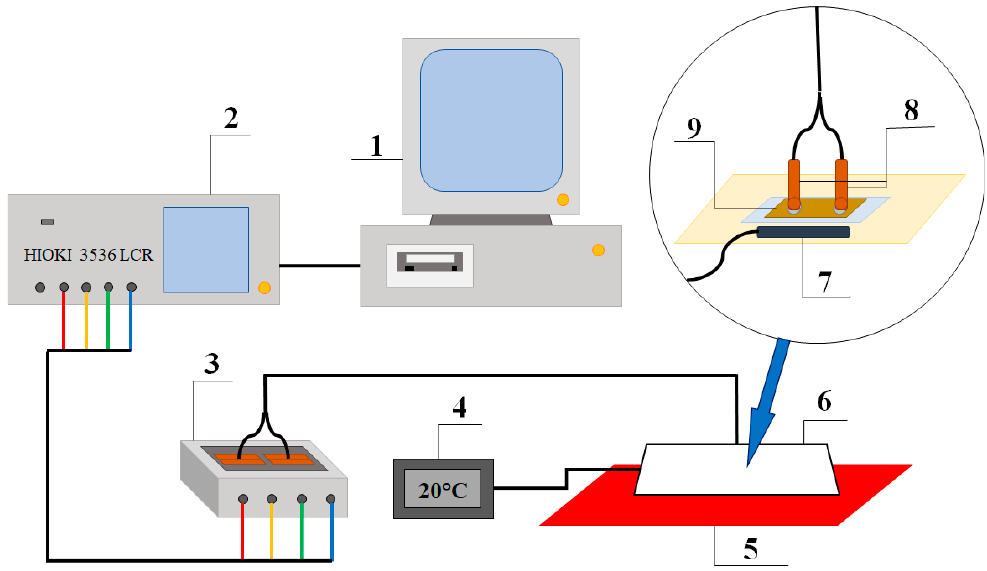
Figure 2. Stand for testing the AC properties of granular nanocomposites in the frequency range from 4 Hz to 8 MHz and in the temperature range from room temperature to 393 K, consisting of: 1—PC running the MATLAB program, 2—impedance meter HIOKI 3536, 3—4-point HIOKI 9261 test fixture relay, 4—temperature display, 5—heating table, 6—Styrofoam housing to maintain the temperature in the test sample environment, 7—temperature sensor, 8—measuring contacts, 9—tested sample.